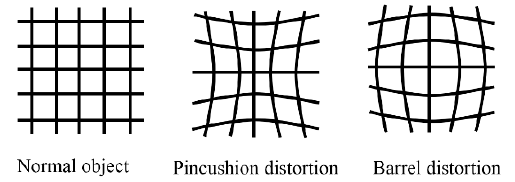
Figure 3. Normal image and distorted image.